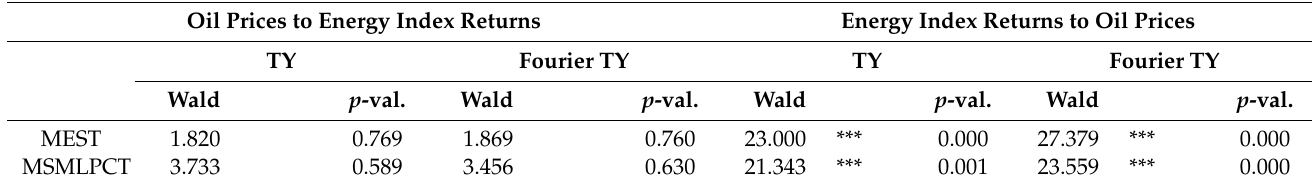
Table 2. Results for price and volatility transmission between oil prices and energy equity index